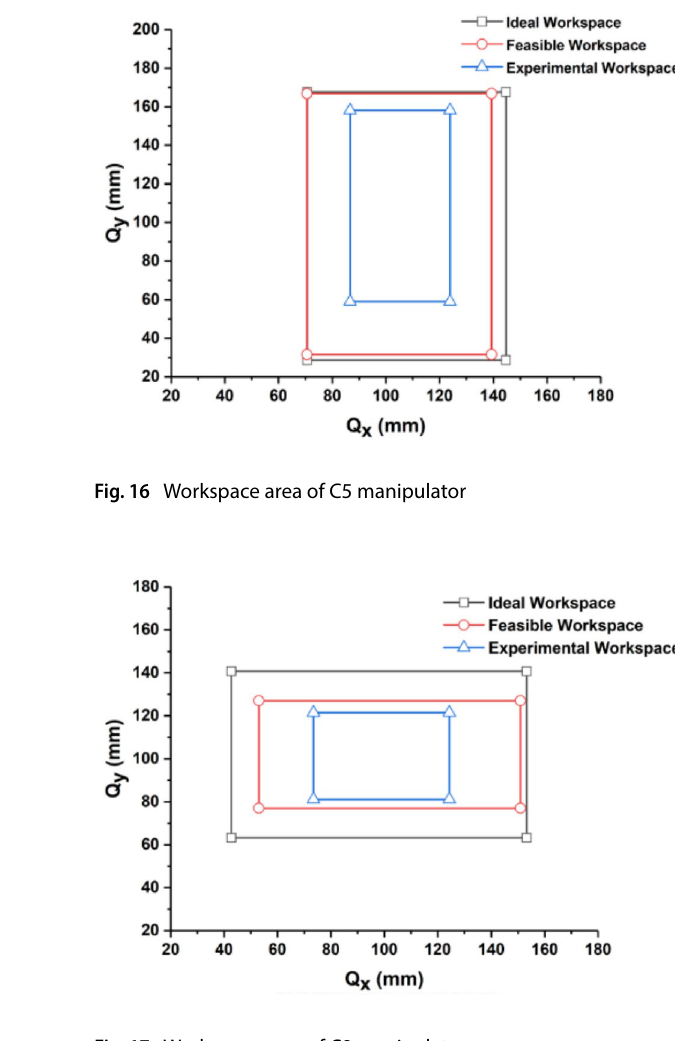
Fig. 17 Workspace area of C8